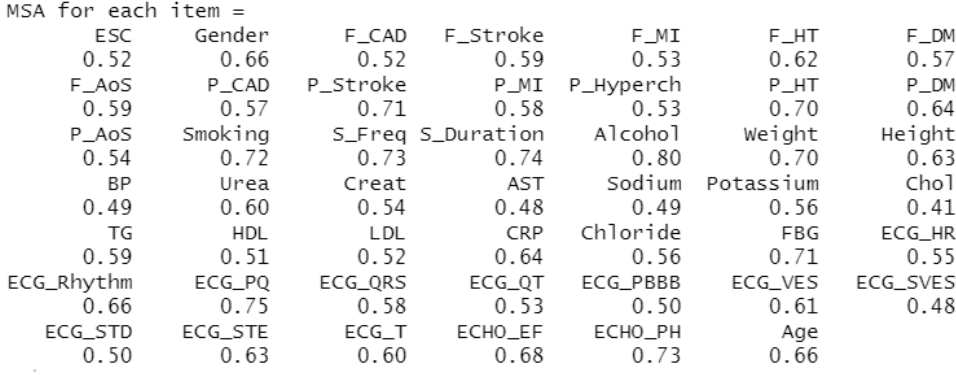
Figure 6. Representation of Scree plot to determine the number of factors .